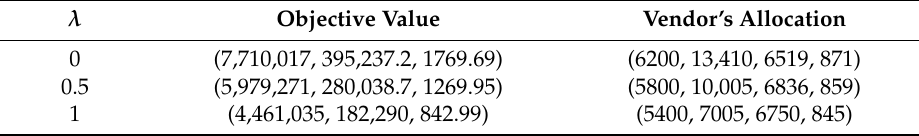
Table 11. Compromise objective value and allocation for case 1 without fixed